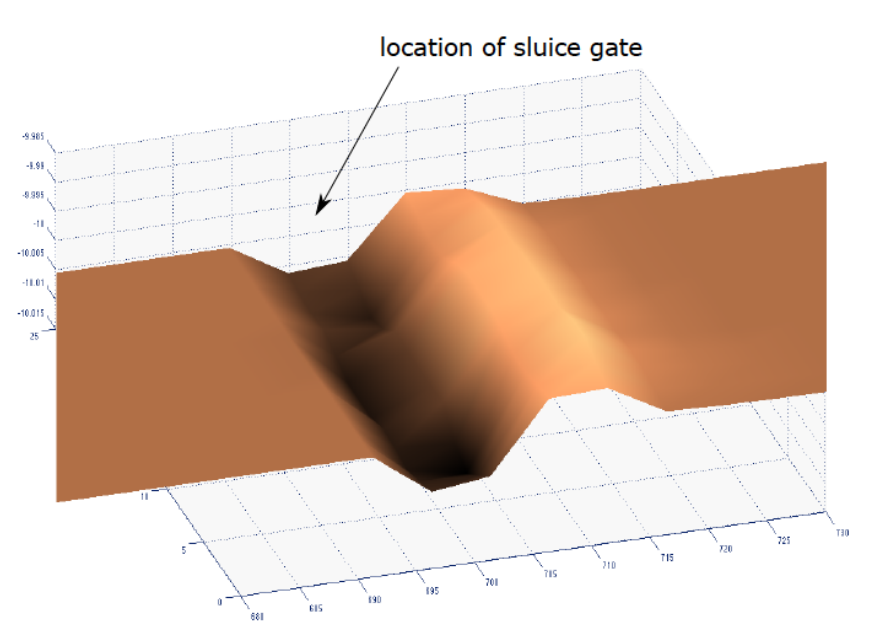
Figure 8. Scouring under a sluice gate (not shown) with the latter modeling scheme. No irregularities are